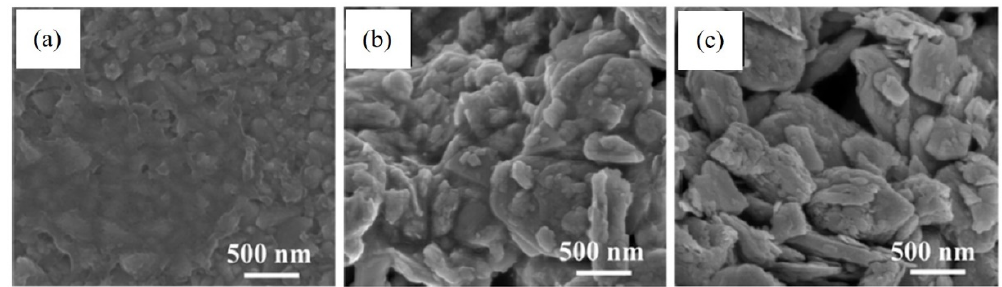
Figure 11. FE-SEM images show the surface morphology of ( a ) bare PEDOT:PSS, ( b ) MP-1.00, and ( c ) bare MoSe 2 [46].